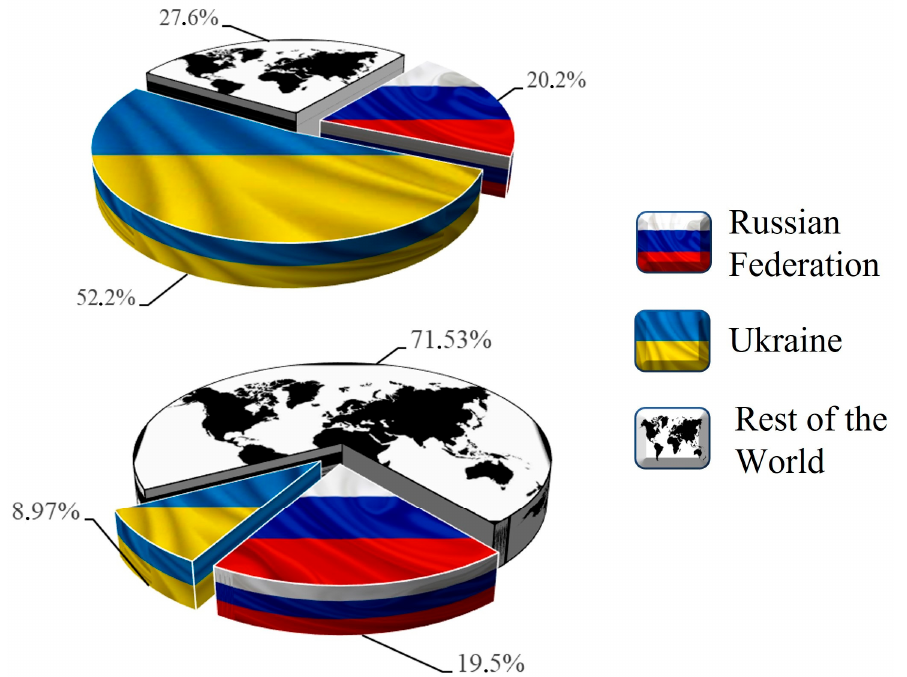
Figure 1. The share of Ukraine, the Russian Federation, and the rest of the world in the global exports of sunflower-seed or oil (crude) on the top, and wheat on the bottom, during 2021. Data obtained from the official website of the Observatory of Economic Complexity (OEC) (https://oec.world/en) (accessed on 14 October 2022).